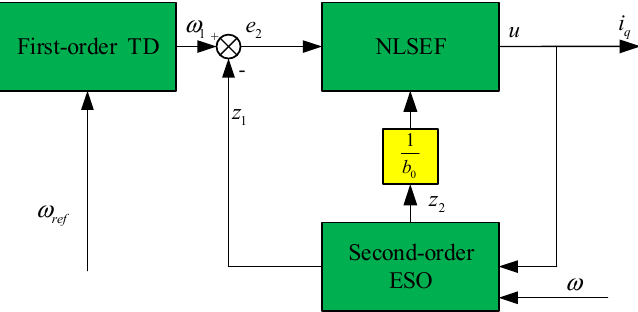
Figure 1. First-order ADRC control structure block diagram of a PMSM.